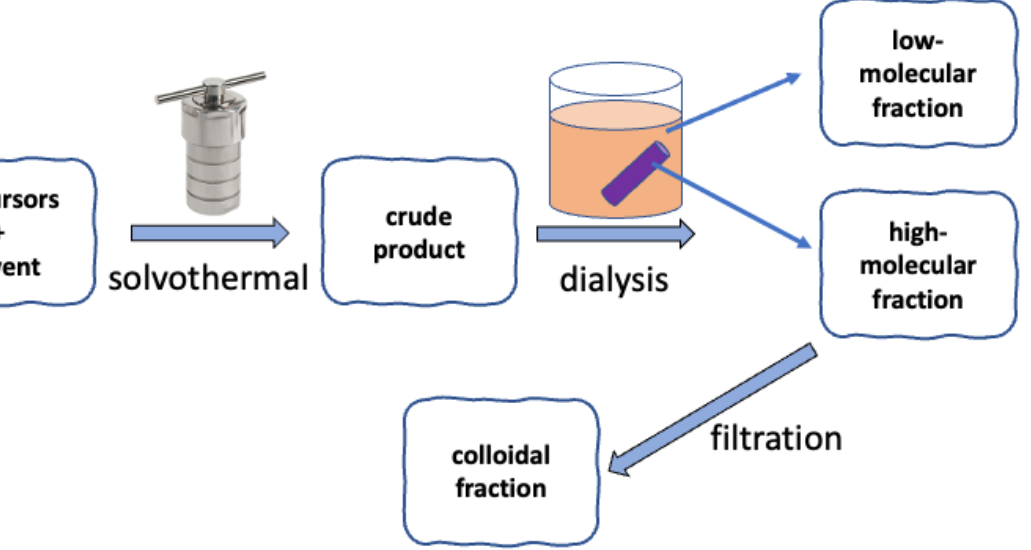
Figure 1. Scheme of preparation and separation of the considered low-molecular and colloidal products of the solvothermal treatment.